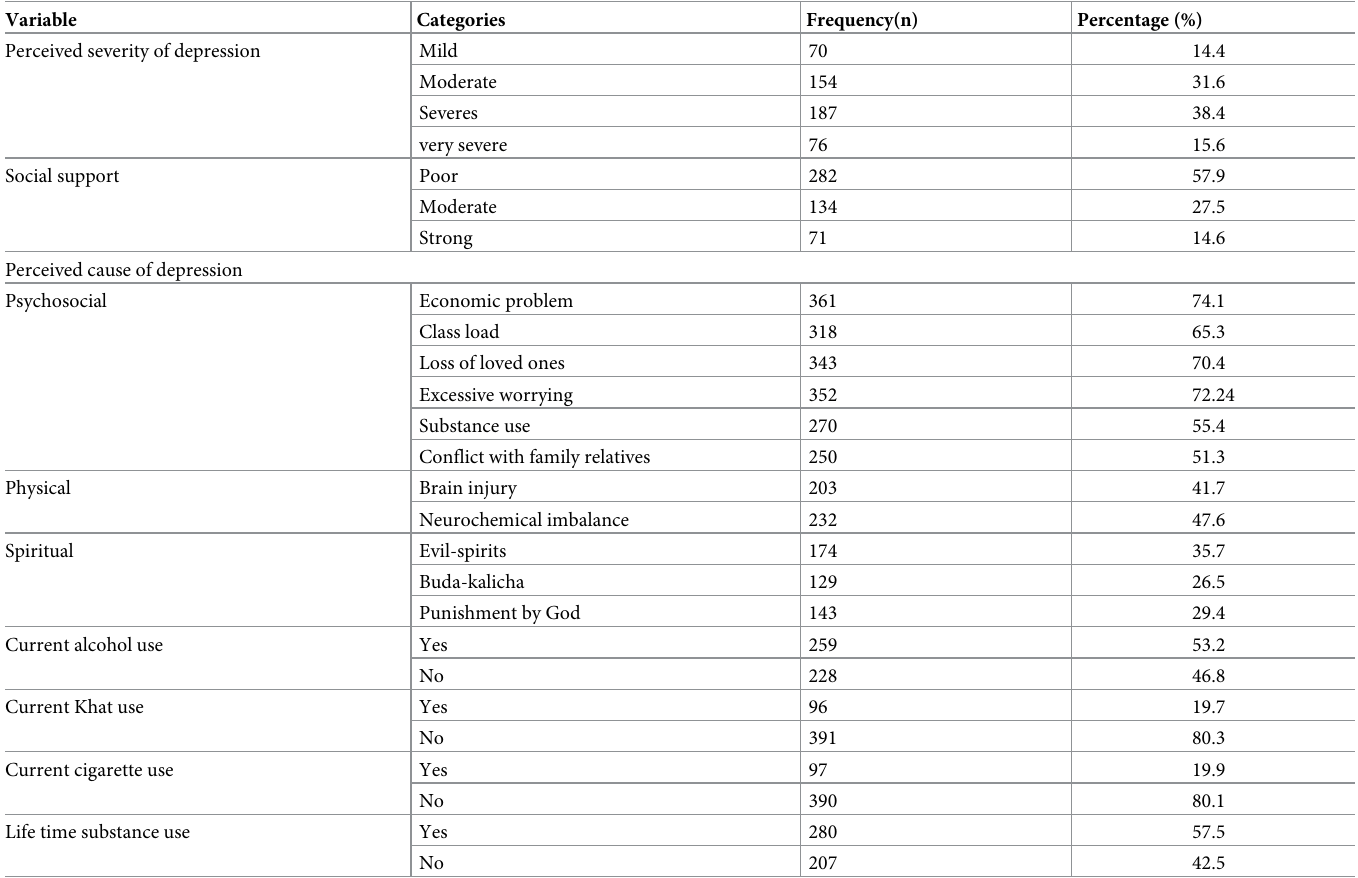
Table 2. Description of clinical, psychosocial and substance use related features of undergraduate students of university of Gonder, northern part Ethiopia (n =